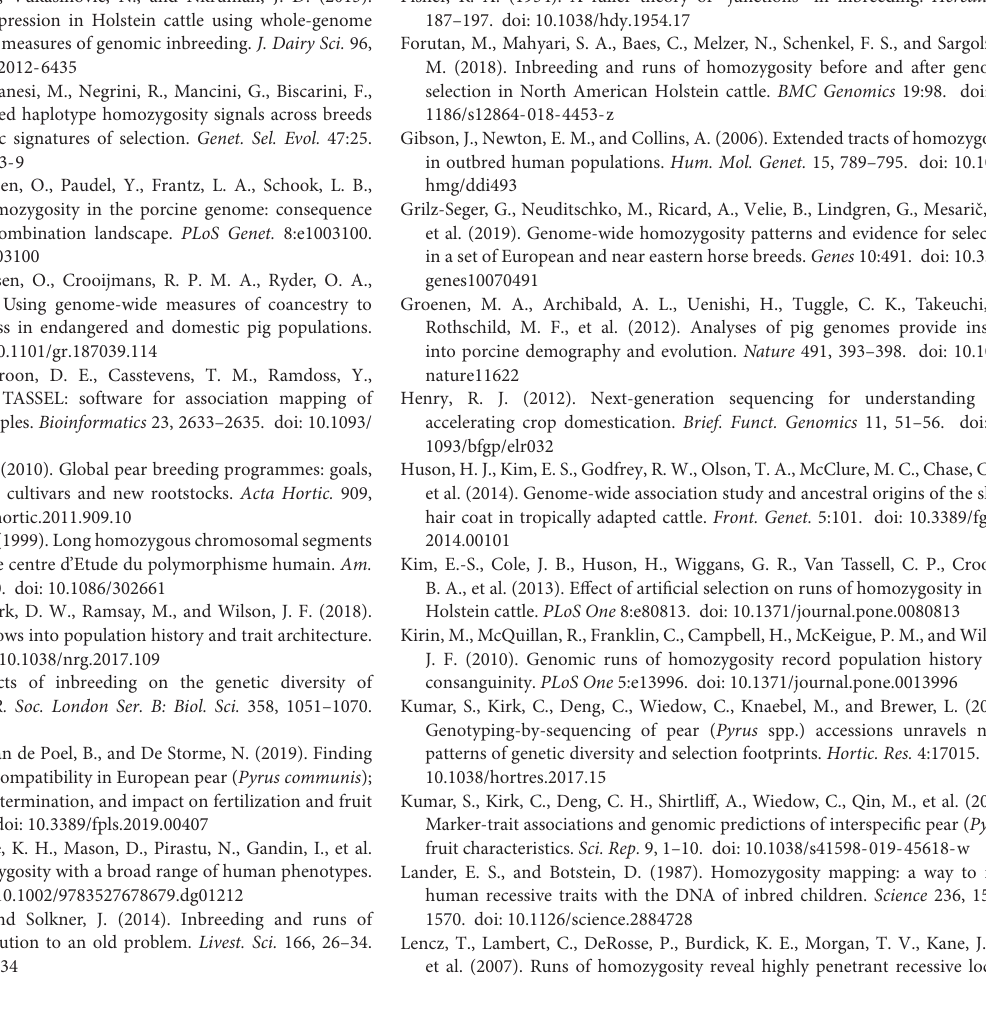
Frontiers in Plant Science |